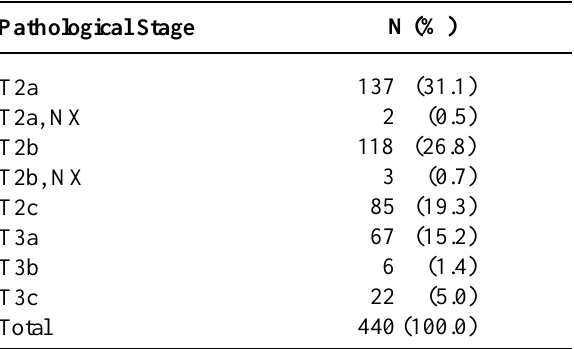
Table 3 – Patient distribution according to pathological stages.